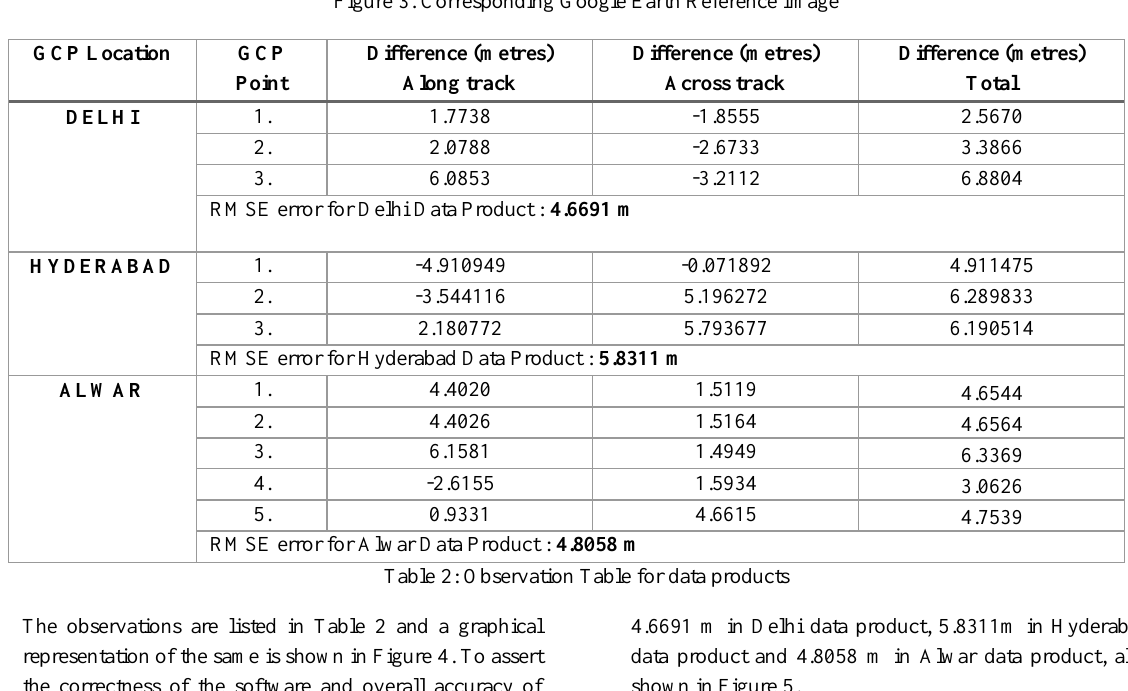
Figure 3. Corresponding Google Earth Reference Image